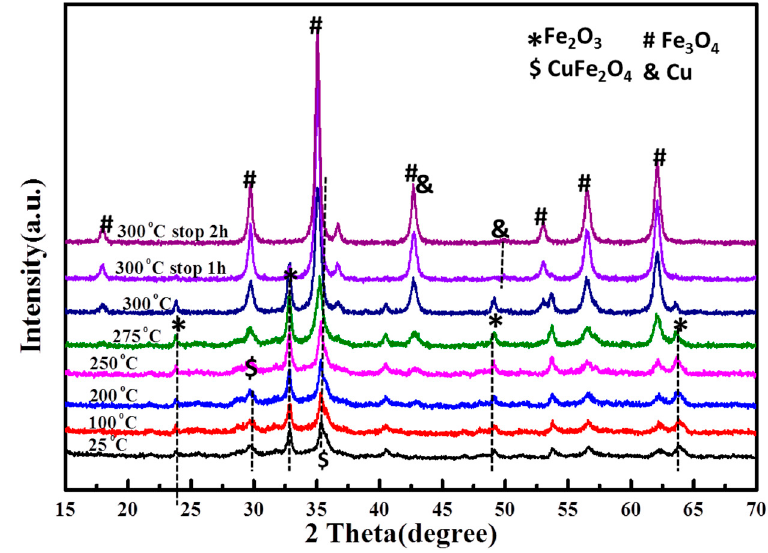
Figure 4. In situ XRD patterns of Cu-Fe-O x nanorods samples reduced in 5% H 2 /N 2 at different temperatures.